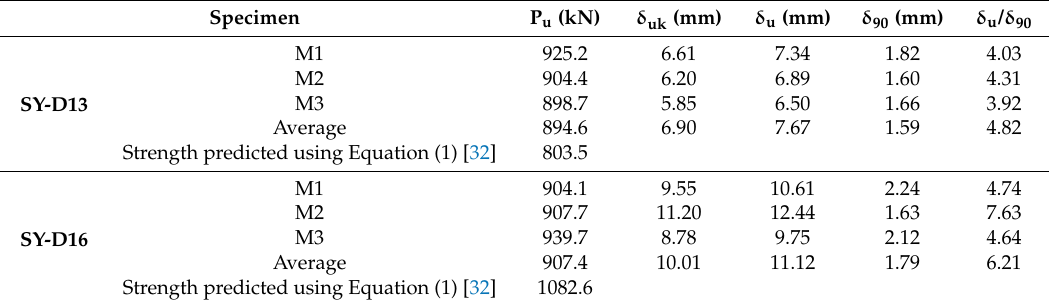
Table 5. Push-out test results .